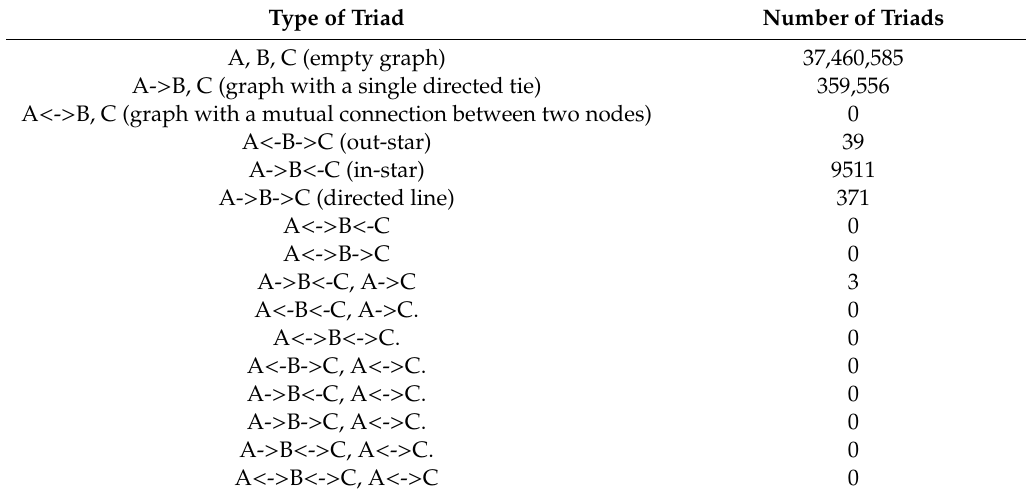
Table 6. Triad census of a manure trade network in the three studied